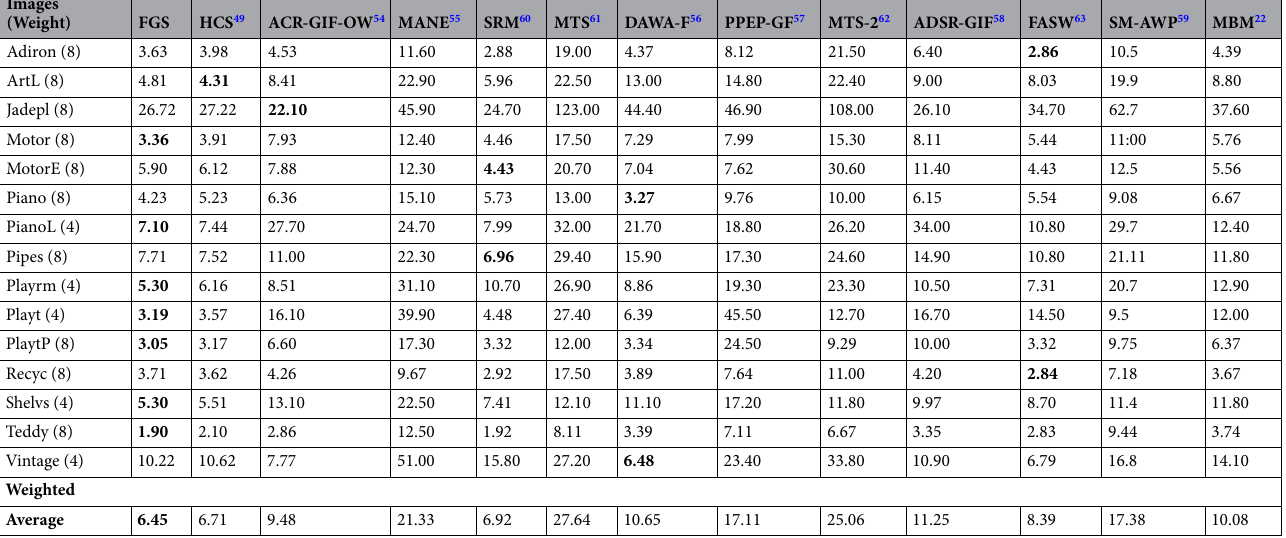
Table 6. Performance (Avg. err) of the FGS algorithm vs state-of-the-art non-learning-based disparity estimation algorithms for stereo pairs in the Middlebury evaluation dataset version 3.0. The weight of a stereo pair represents the level of difficulty in estimating disparity map from the respective stereo pair. The algorithm with the highest performance is highlighted in bold.